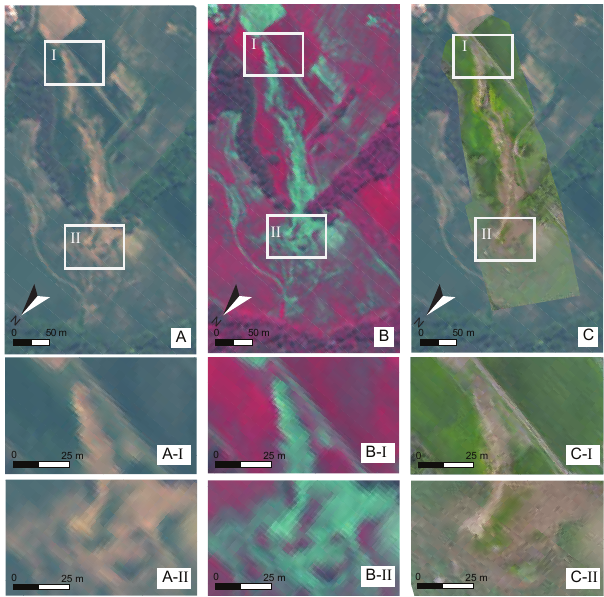
Figure 2. Images used to map the Assignano landslide. (a) TC WorldView-2 satellite image, (aI) detail of the source area and (aII) detail of the landslide deposit. (b) WorldView-2 satellite im- age in FCC, (bI) detail of the source area and (bII) detail of the landslide deposit. (c) UAV monoscopic image and (cI) a detail of the source area and (cII) a detail of the deposition area.